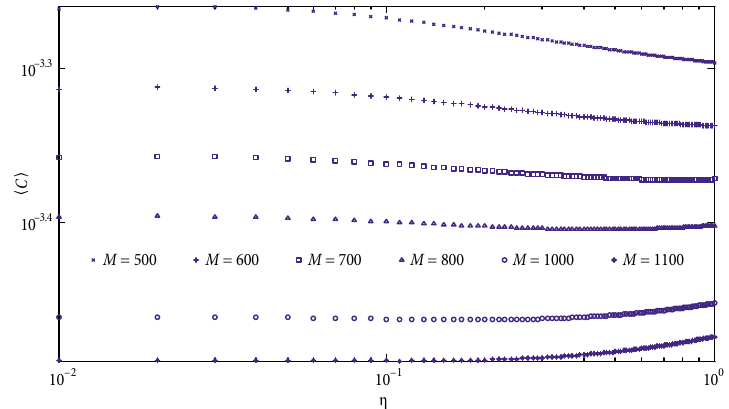
Fig. 8. The average clustering coefficient C of the network of credit risk contagion as a function of the average fitness h of credit risk contagion in the network, for different network size M ,